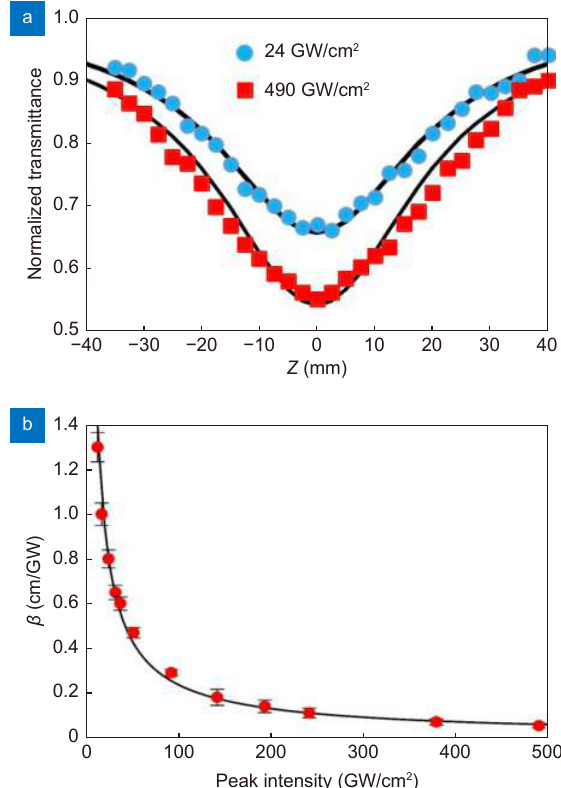
Fig. 5 | ( a ) Open aperture Z scan data of polycrystalline ZnSe at I 0 = 24 GW cm –2 and 490 GW cm –2 with best fits to β = 0.8 cm GW –1 and β = 0.05 cm GW –1 respectively. ( b ) Measured effective 2-photon ab- sorption coefficient β versus peak intensity of 0.05 cm polycrystalline ZnSe which reaches β = 1.3 cm GW –1 at intensity I 0 = 13 GW cm –2 , decreasing to β = 0.05 cm GW –1 at 490 GW cm –2